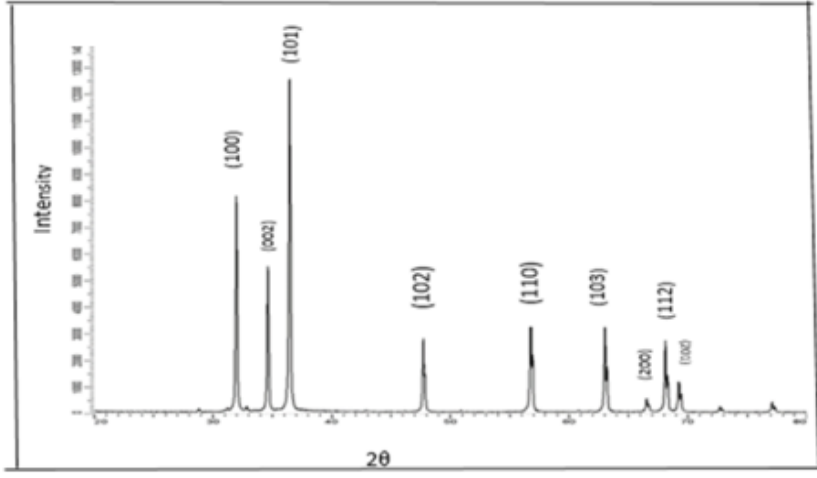
Fig. 2: X-Ray diffraction pattern of ZnO thin